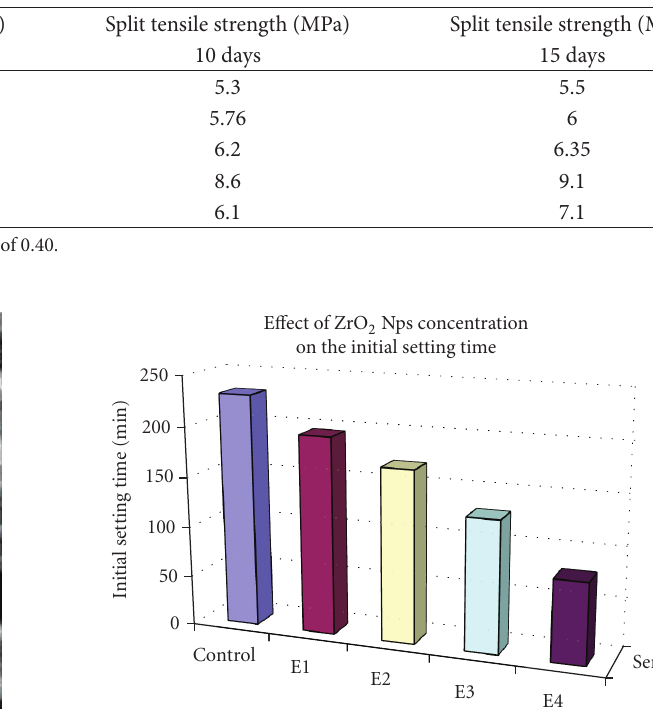
NPs, with diameter about 100nm. 2